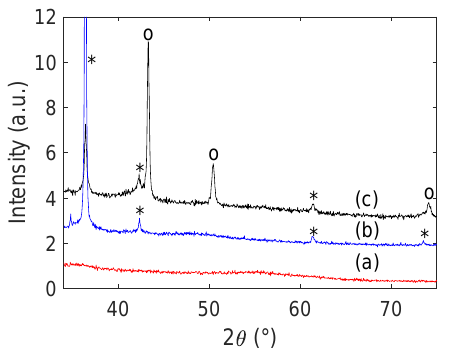
Figure 3. X-ray diffractograms of particles from the sonochemical synthesis. Carbon supported Pt-nanoparticles are shown in red (a), while Cu-samples synthesized before the addition of PtCl 4 are shown in blue (b), and Cu-samples synthesized after the addition of PtCl 4 are shown in black (c). Peaks corresponding to the Cu 2 O phase (*) and the metallic Cu phase (o) are marked in the figure. The cyclic voltammograms of the Pt-, Cu 2 O-, and Cu@Pt-samples are shown in Figure 4. For the Pt-sample (a), the characteristic CV of Pt was observed [13] confirm-